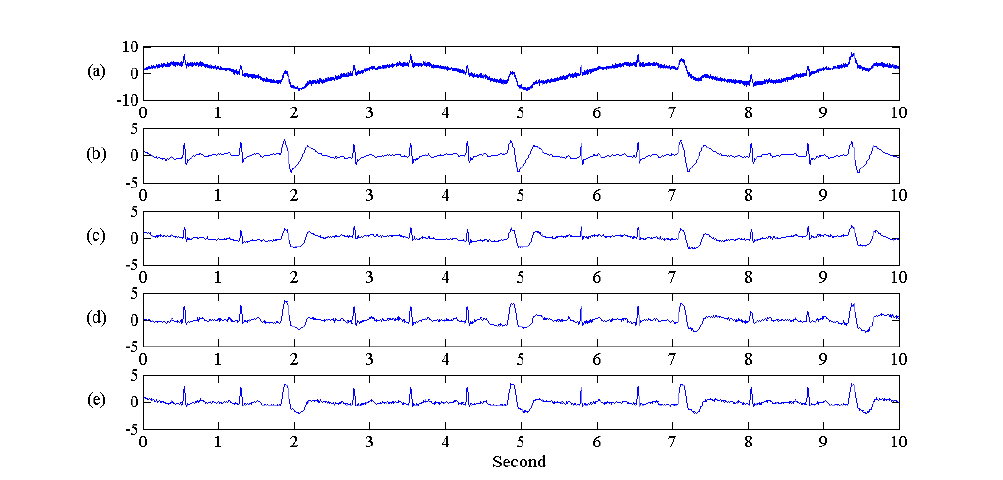
Figure 9. From top to bottom: (a) ventricular arrhythmia ECG (V1) with 100% composite noise